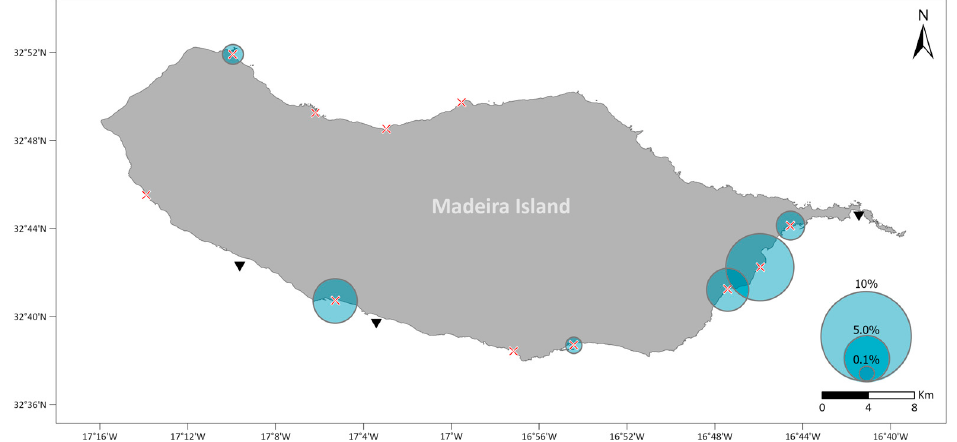
Figure 4. Percentage of S. aurata caught from fishing contests in the period 2017–2019. The size of the circle represents the mean percentage of S. aurata recorded in each fishing contest location. The fishing contest sites are represented by red crosses and the aquaculture facilities by black triangles.